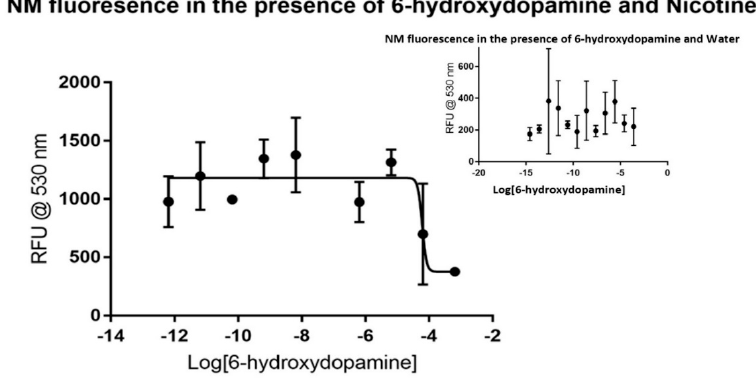
Figure 3. Fluorescence of synthetic neuromelanin upon exposure to 6-hydroxydopamine in the absence (inset) and presence of nicotine as a signal molecule. As with MPP + and dopamine, 6-hydroxydopamine itself did not appear to reveal a signal that could be related to saturation binding kinetics when added to NM, but in the presence of nicotine displayed increased and more stable average quadruplicate RFU values. In this case, an inflection appears near 10 − 4 M 6-hydroxydopamine by non-linear regression analysis, suggestive of a saturable binding a ffi nity in the 0.1 mM range for 6-hydroxydopamine to NM-Fe 3 + in bu ff ered aqueous solution. As in all prior cases, points presented are the average of quadruplicate measurements with error analysis performed with GraphPad Prism TM